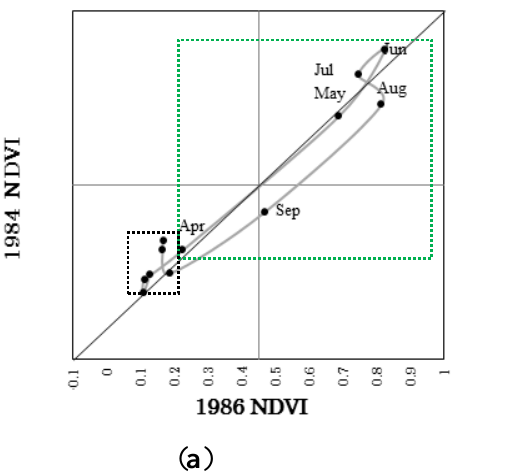
Figure 6. Monthly NDVI trajectories of ( a ) a normal year and ( b ) the fire year. The points within the green box represent the growing season (April to October), while the points within the black box represent the snow cover season (November to March). The red point represents the month that the fire